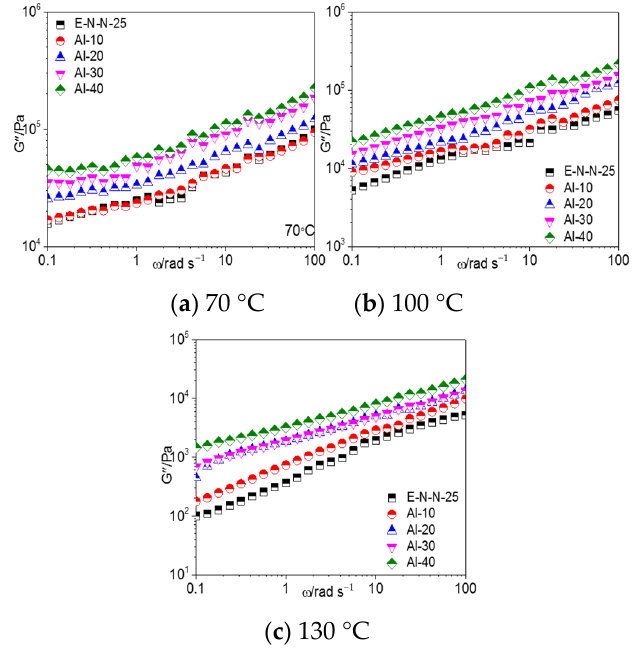
Figure 4. G ″ – ω curves of model propellants with different Al powder contents.